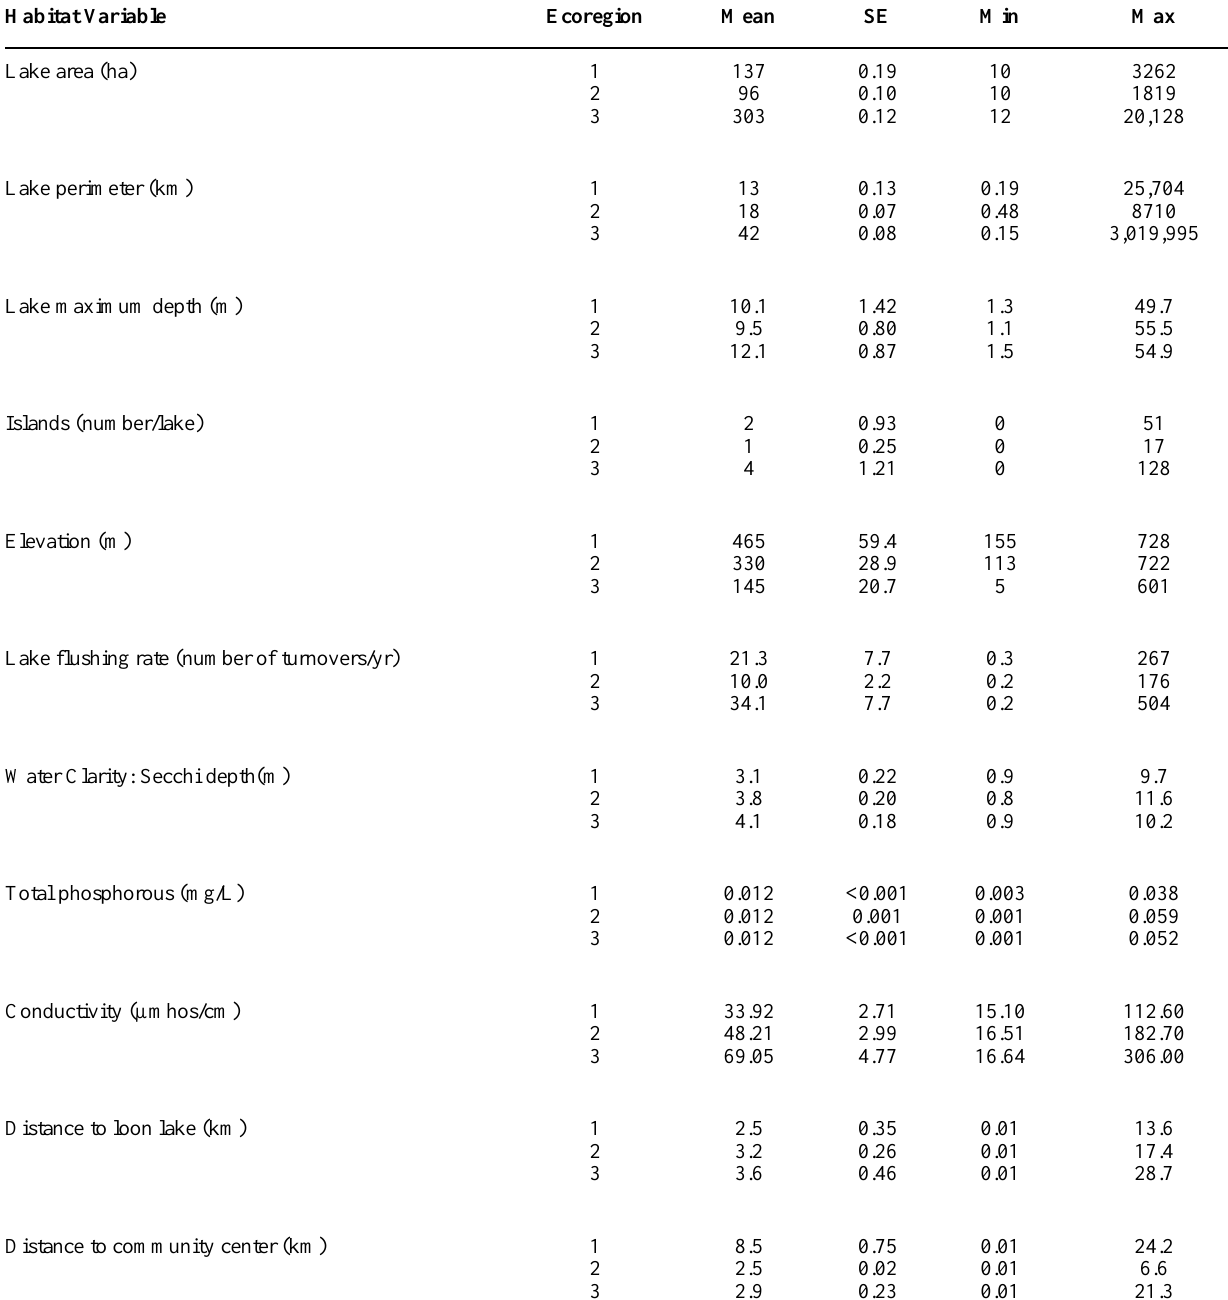
Table 3 . Summary of lake habitat for the three ecoregions for selected explanatory variables. Means include both Common Loon nest presence and absence